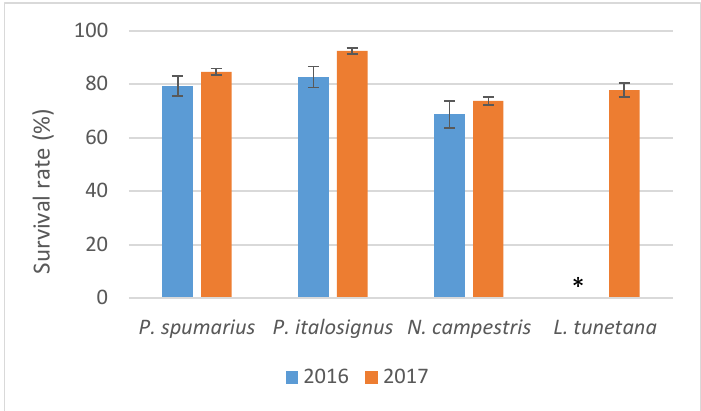
Figure 1. Survival (%) recorded in 2016 and 2017 upon four days of acquisition access period on olives for Philaenus spumarius , P. italosignus , Neophilaenus campestris and Latilica tunetana. * not done in 2016.